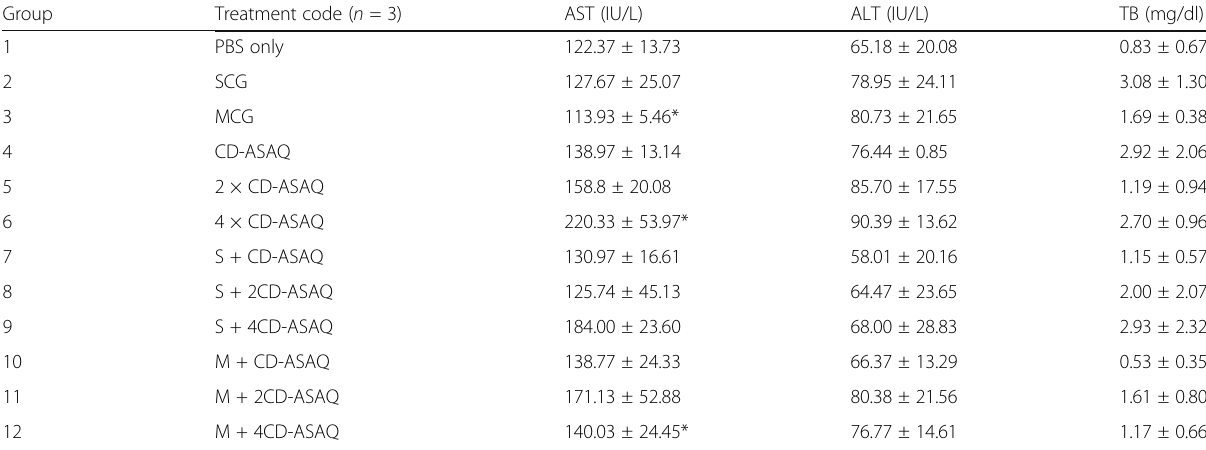
Table 2 Evaluation of the effect of MO leaf extract on AS-AQ intoxicated Wistar rats by using biomarkers of liver injury Group